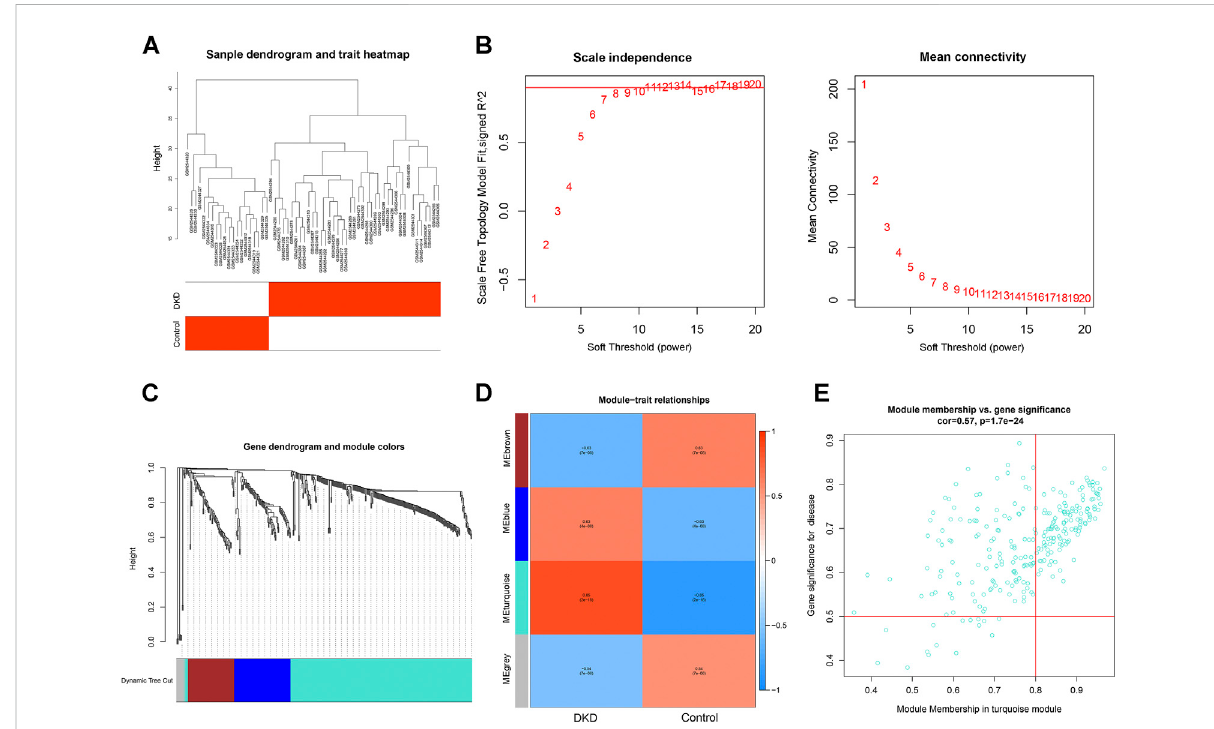
FIGURE 4 Construction of a WGNCA network. (A) Clustering heatmap of control and DKD samples. (B) Scale-free exponent and average connectivity for eachsoftthreshold. (C) Dendrogramofgeneclusters,withdifferentcolorsrepresentingdifferentmodules. (D) Heatmapofthecorrelationsbetween module eigengenes and DKD. Blue and red indicate negative and positive correlations, respectively. The turquoise module with the highest correlationwasselectedforsubsequentanalysis. (E) Scatterplotofgenesintheturquoisemodule.Thehubgenesintheturquoisemodulewere screened according to the criteria of |MM| > 0.8 and |GS| >